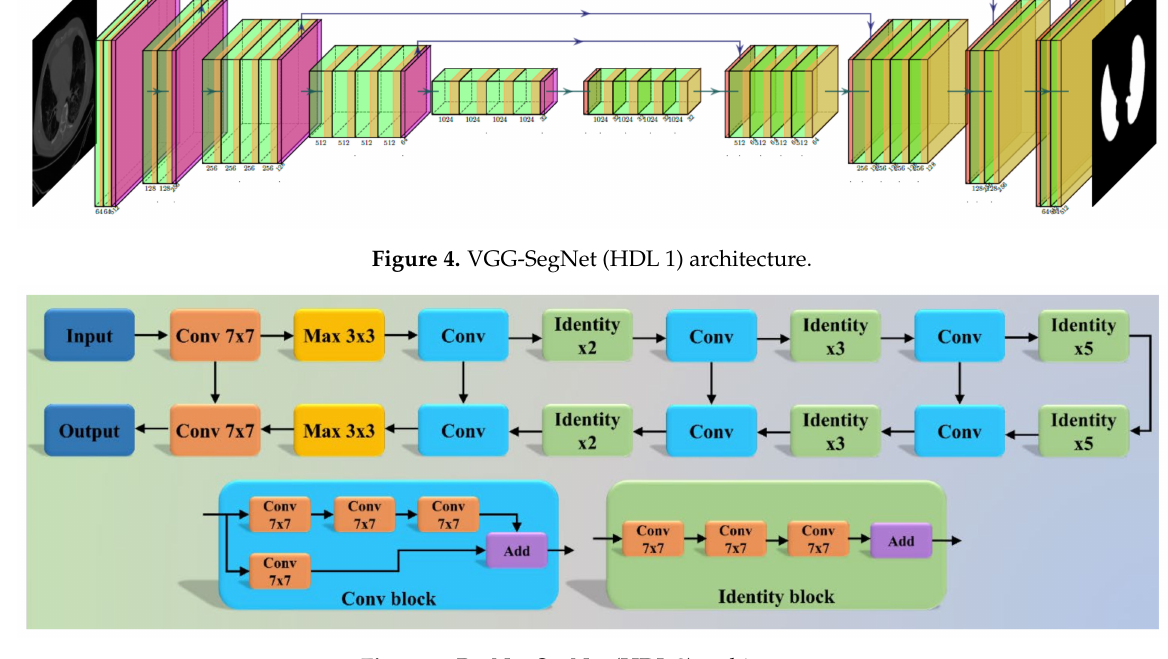
Figure 5. ResNet-SegNet (HDL 2)